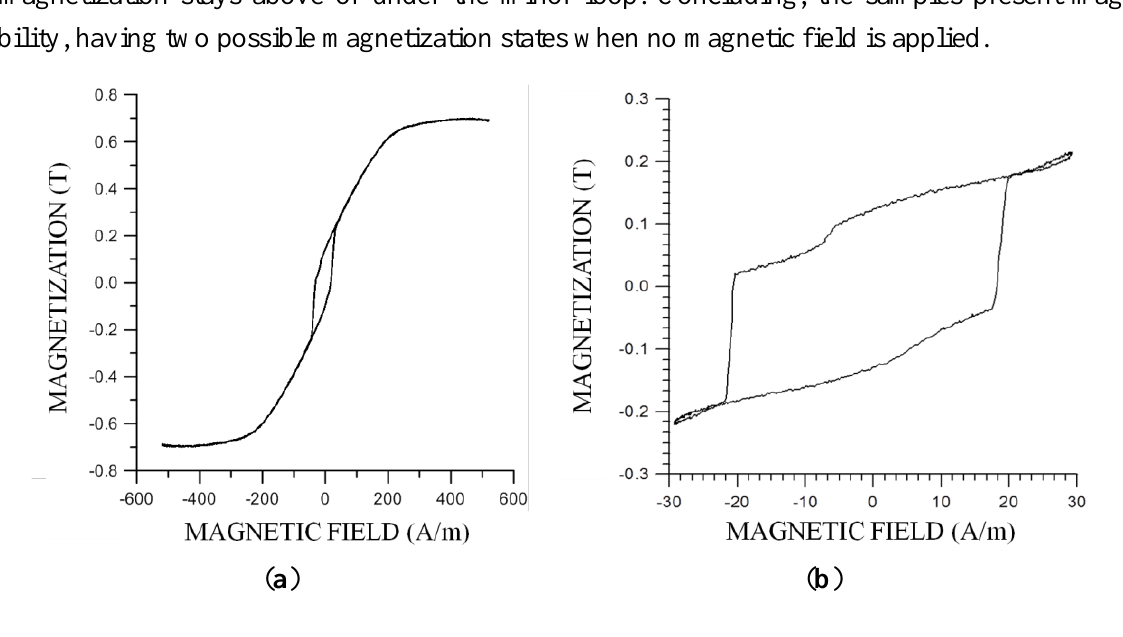
Figure 11. Bistable samples: ( a ) hysteresis loop; ( b ) Minor